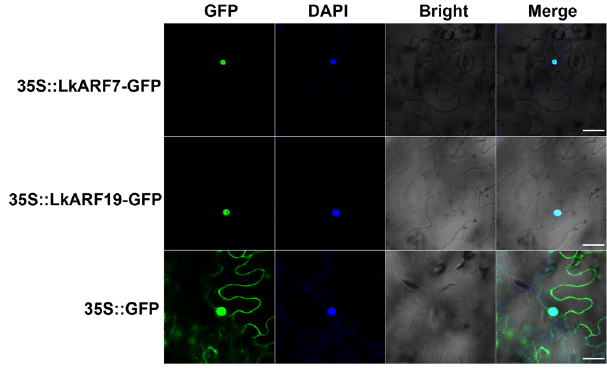
Fig. 2 Subcellular localization of LkARF7 and LkARF19. Subcellular localization of LkARF7 and LkARF19 in tobacco leaf cells after tobacco leaf agroin fi ltration. Scale bars, 30 μ